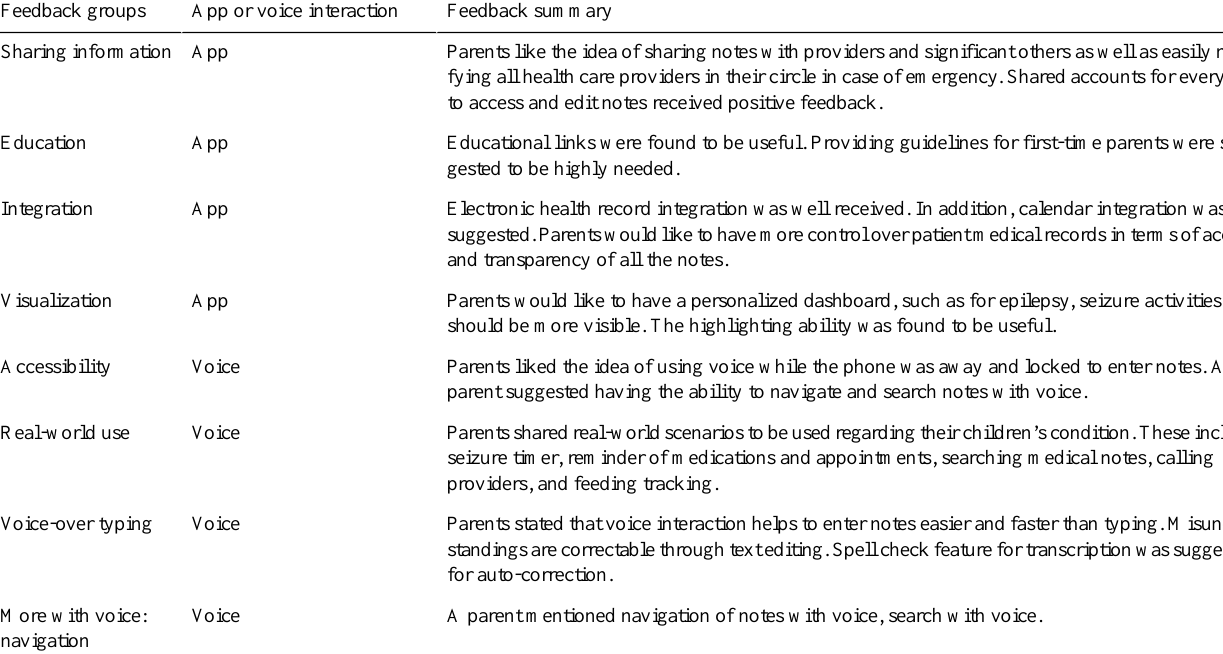
Table 3. Parents’feedback about the SpeakHealth app.